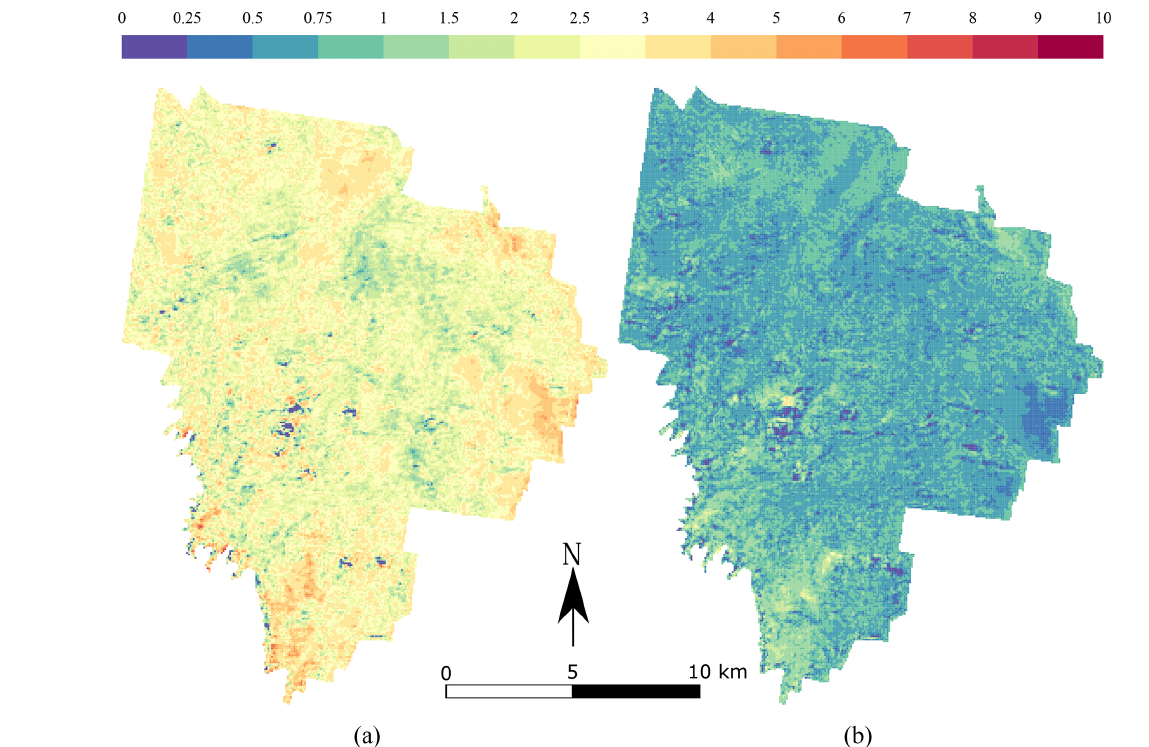
Figure 6. Maps of the prediction of organic carbon for (a) topsoil (0–10cm) and (b) subsoil (40–50cm). The values are expressed in g100g − 1